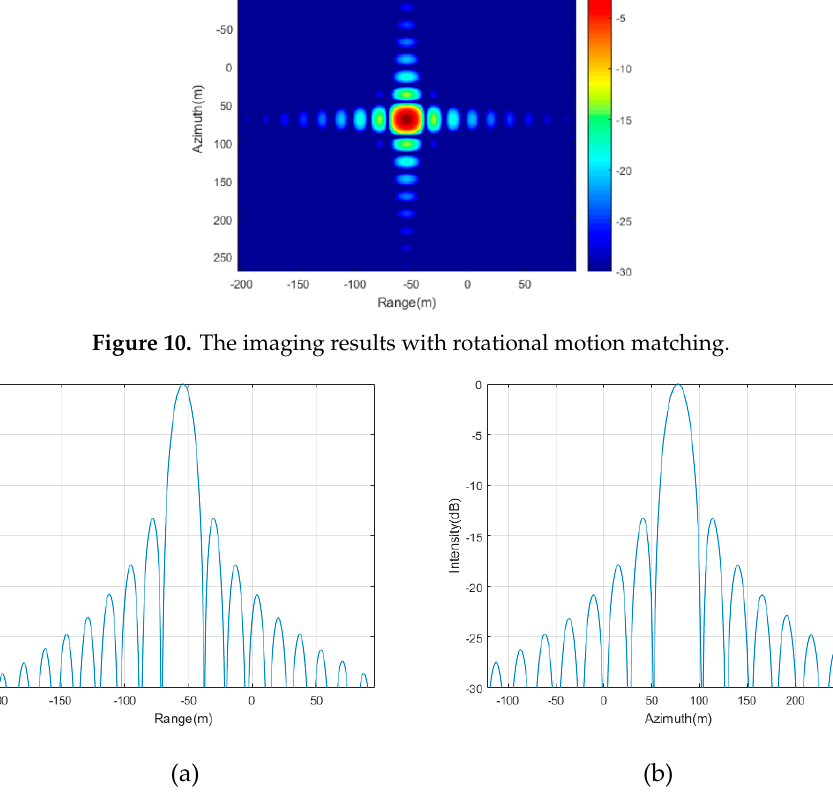
Table 4. The coordinates of five scatter points.